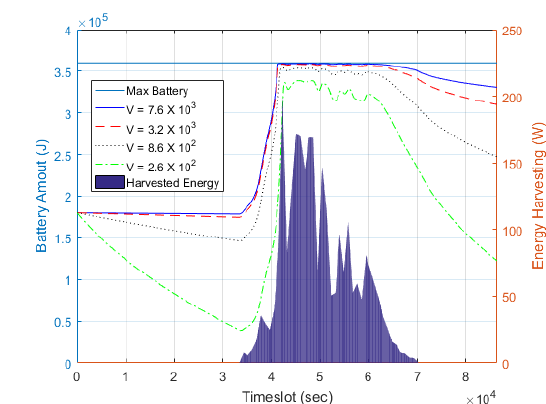
Figure 7. Battery amount vs.